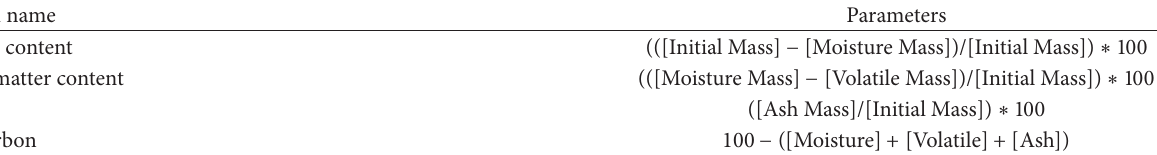
Table 1: Method equation parameters for proximate analysis determination from TGA curve [21].